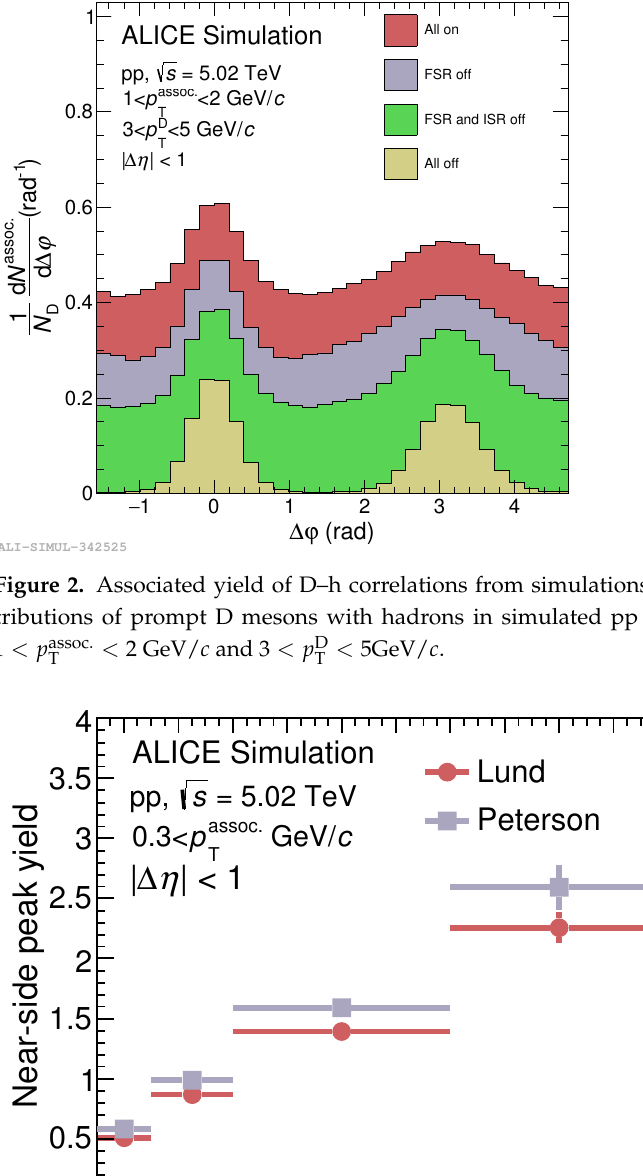
√ s = 5.02 TeV, as a function of the D-meson p T , for p assoc.